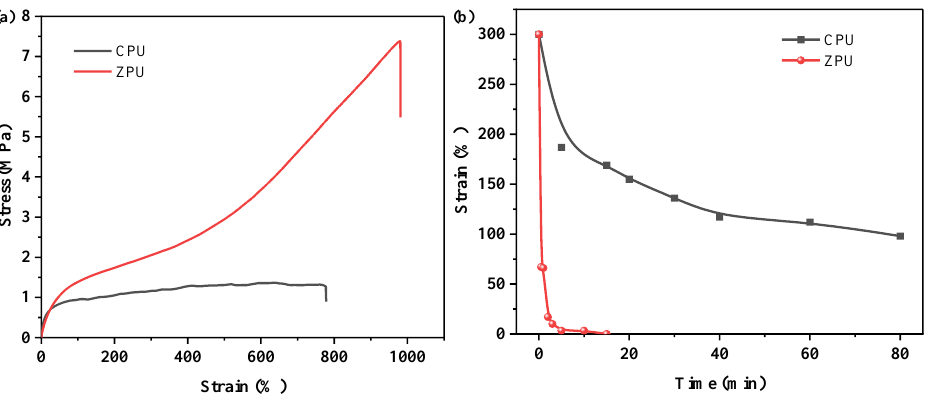
Figure 5. Stress – strain curve ( a ) and elastic recovery property ( b ) of ZPU and CPU. Table 1. Comparison of tensile strength, elongation at break and Young’s modulus. Samples